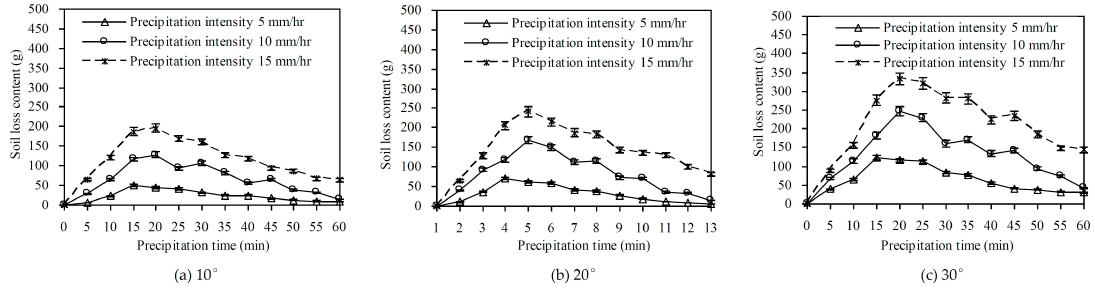
Figure 8. The variation of soil loss at three rainfall intensities with rainfall duration on slopes of three gradients.